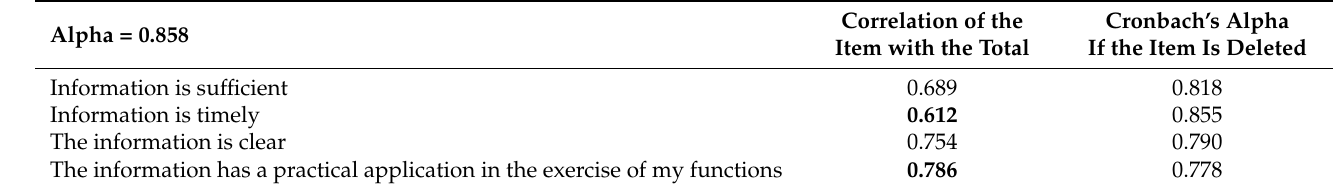
Table 2. Reliability of the dimension—Institutional